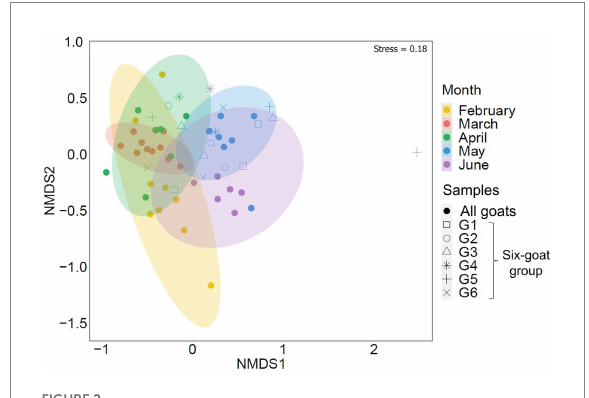
FIGURE 2 Similarity of the overall arthropod community (ASVs) detected in goat fecal samples by sampling month (February–June). The nonmetric multidimensional scaling analysis (NMDS) is based on Bray–Curtis dissimilarity matrix with 95% confidence ellipses. Each point represents the arthropod composition of a single fecal sample. Samples belonging to the six-goat group (goats with at least three consecutive samples from April–June, G1-G6) are marked by open shapes. The samples clustered together by sampling